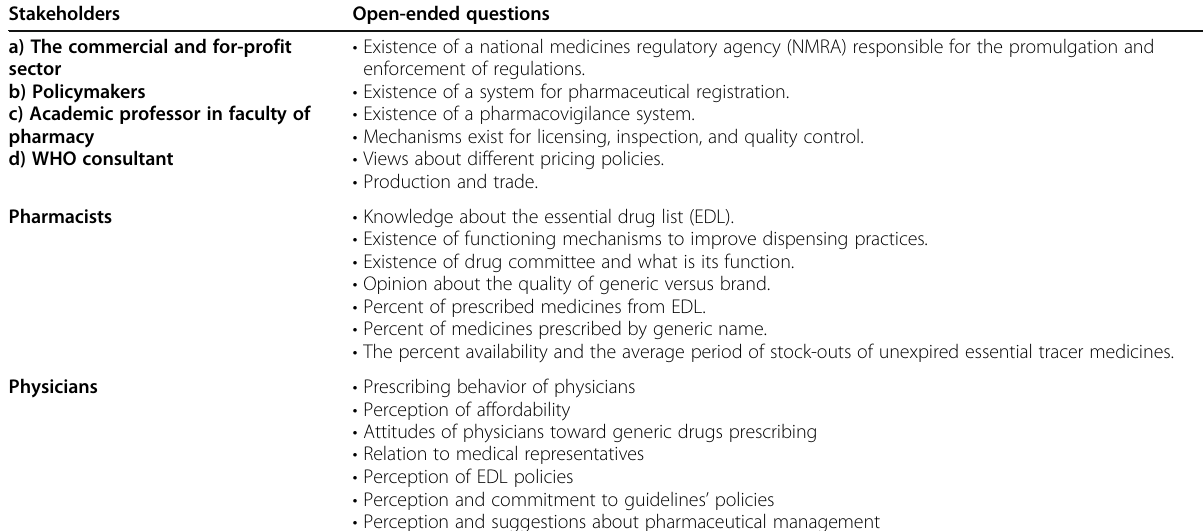
Table 1 In-depth interview guide with variant stakeholders Stakeholders Open-ended